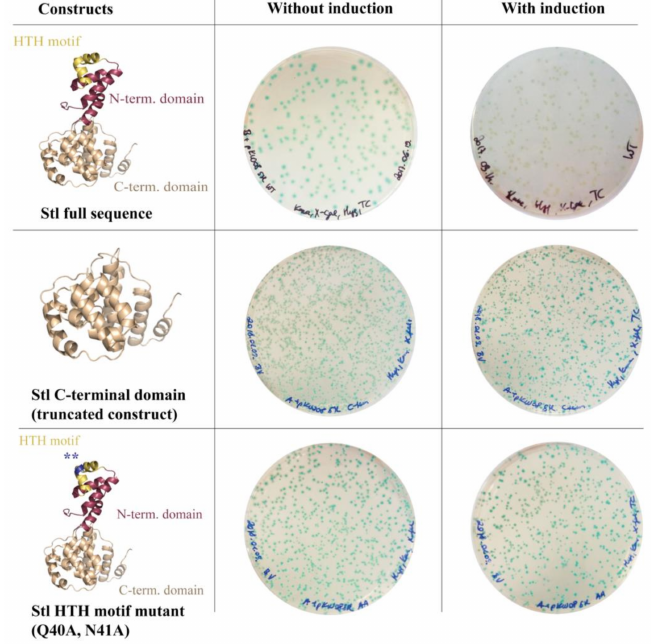
Figure 3. Validation of the switch system: To test the system functionality, several Stl constructs with various DNA-binding abilities were used. Without induction, i.e., in the absence of the Stl expression inducer tetracycline, cells form blue colonies in all cases. Upon the induction of the full-length wild-type Stl, white colonies are formed as Stl is able to fully repress the lacZ gene. Both the truncated Stl C -terminal domain construct and the HTH motif mutant Stl have diminished DNA-binding ability [8] and, as expected, their expression in M. smegmatis leads to the formation of blue colonies. Note that the difference in the number of colonies between variants represents the transformation